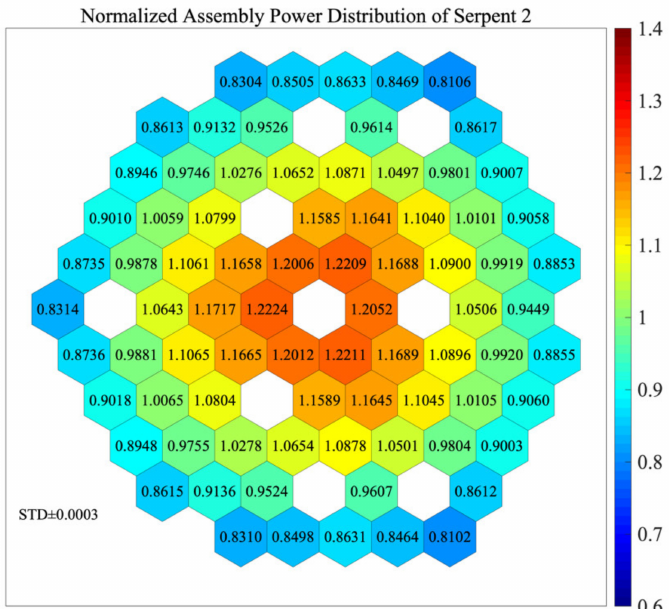
Figure 5. Normalized assembly power distribution of Serpent 2 at operation loading with control-rod